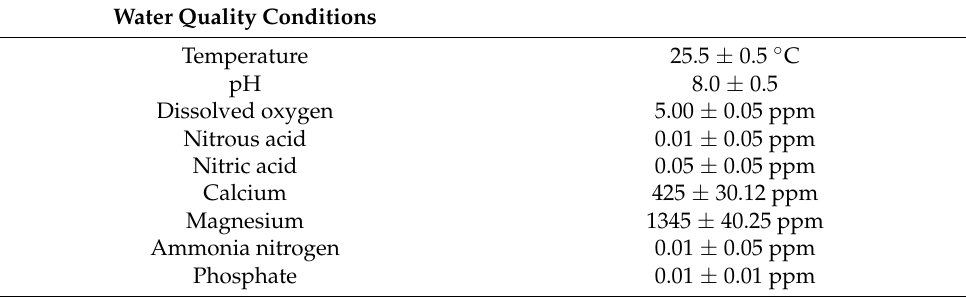
Table 1. The water quality conditions in the